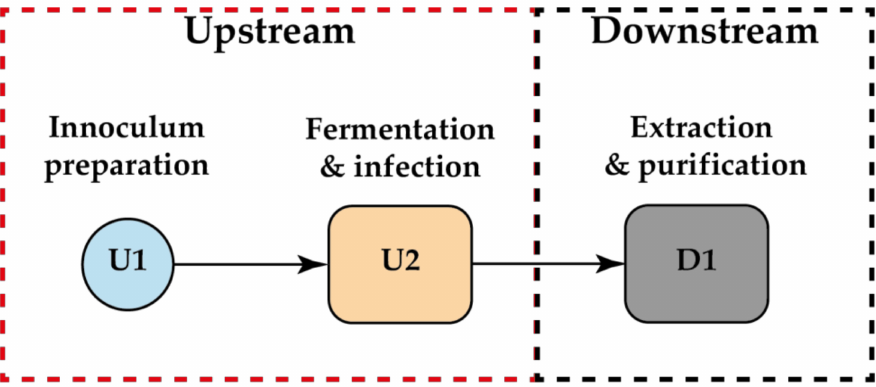
Figure 1. Process description of influenza vaccine